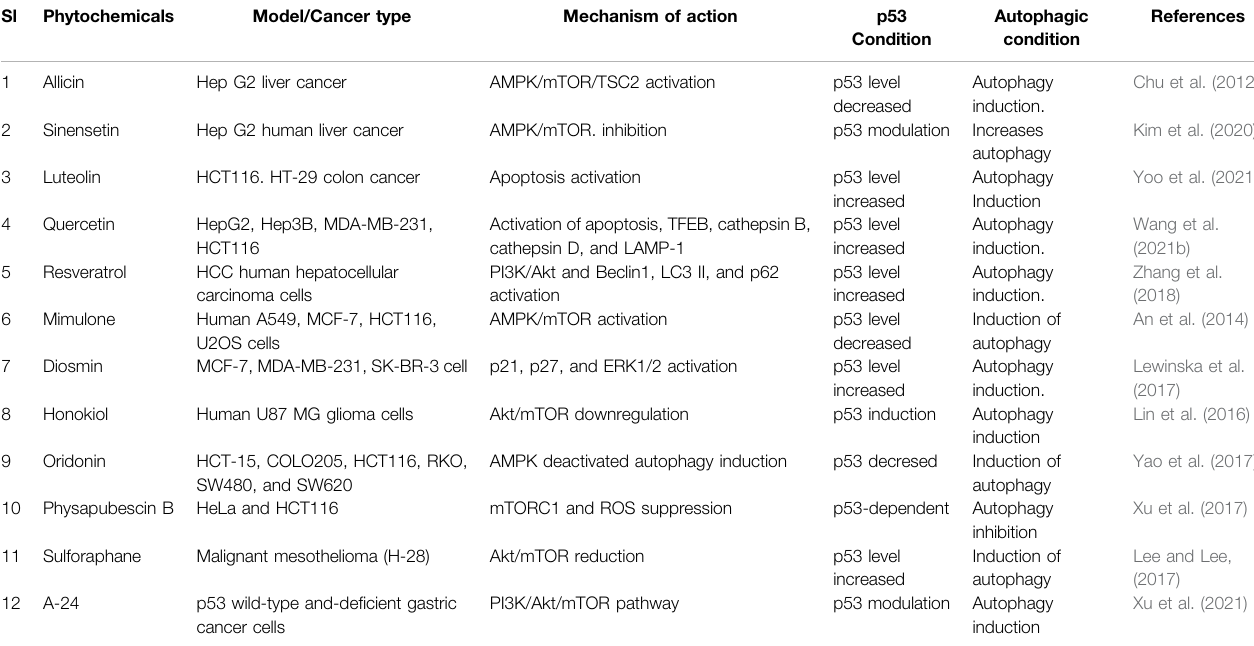
TABLE 2 | Numerous phytochemicals used as a therapeutic target of p53-mediated autophagy modulation in